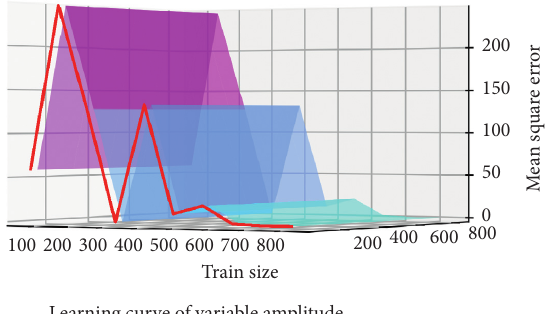
Figure 19: Learning curve of variable amplitude.